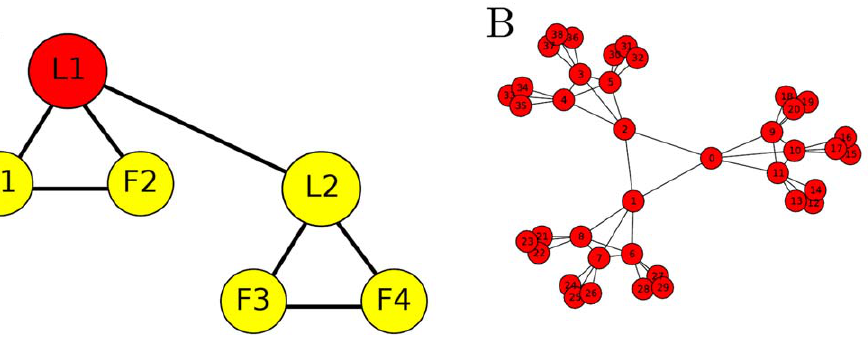
Figure 1. The French World-War II underground network Francs-tireursetPartisans (FTP) reconstructed by the author based on the account in [ 20 ] . Its organizational unit was the combat group (A). In an idealized case, nor always followed, this was divided into two ‘‘teams’’ of three fighters, where leader L1 was in overall command and in command of team 1 . His lieutenant, L2, led team 2 and assumed overall command if L1 was captured. The small degree of the nodes ensured that the capture of any one node did not risk the exposure of a significant fraction of the organization. Each ‘‘group’’ is in a command hierarchy (B) where 3 groups (bottom-level nodes) made a ‘‘section’’, 3 sections made a ‘‘company’’, and finally 3 companies made a ‘‘battalion’’.